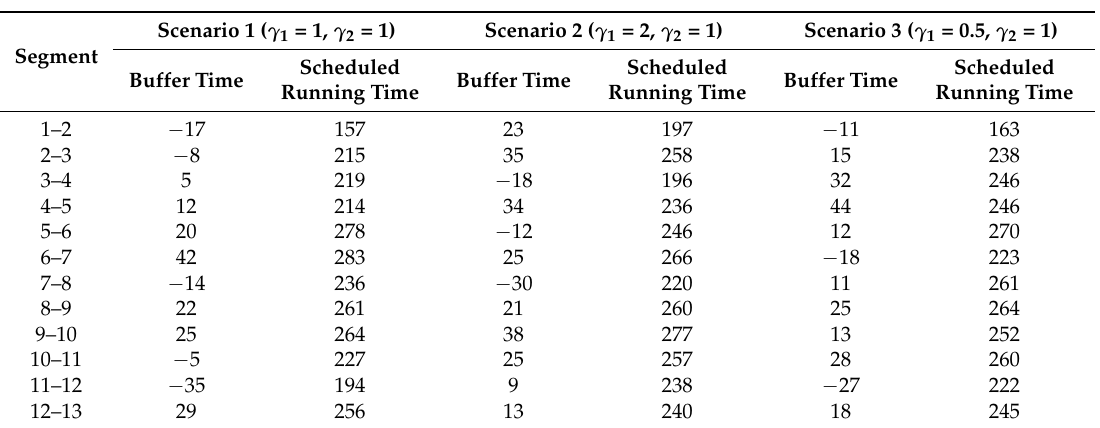
Table 5. Optimized results. Unit: s.